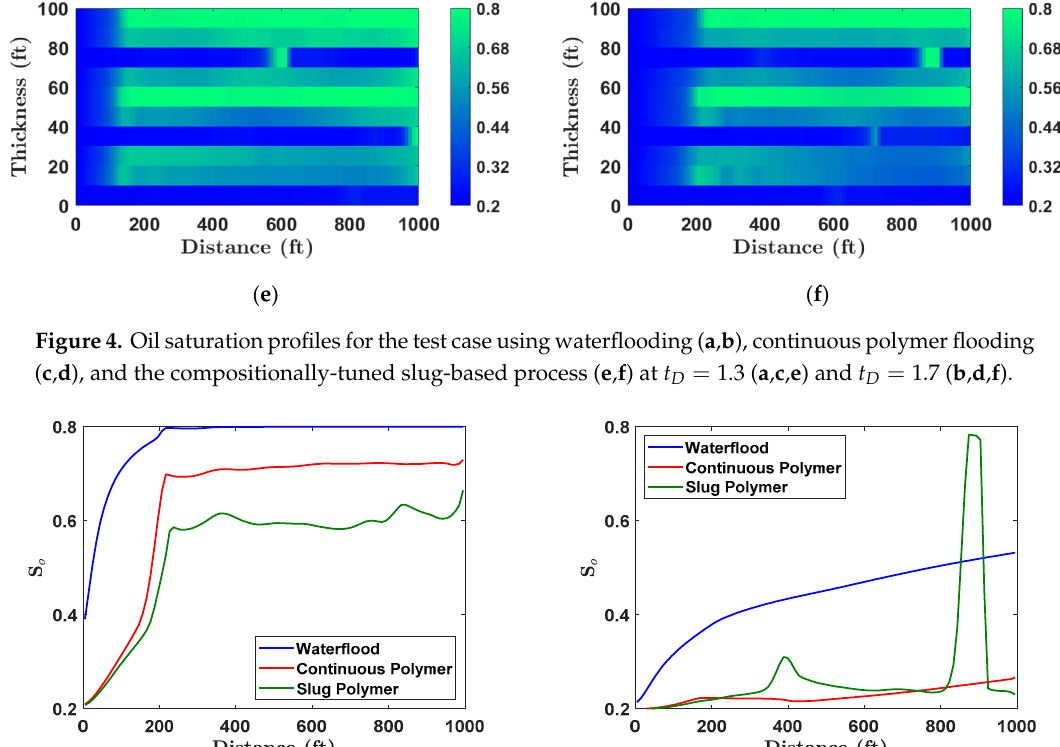
Figure 5. Oil saturation profiles for the test case in layer nine ( a ), and layer eight ( b ) at